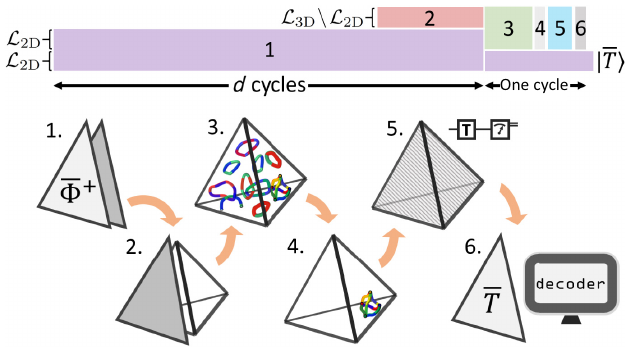
FIG. 29. Protocol to create an encoded T state via code switch- ing, with the timeline of each step in units of QEC cycles for the 2D color code. In steps 1 and 2 we simultaneously prepare the Bell state | (cid:19) + (cid:2) in a pair of 2D codes, and the interior of the 3D subsystem color code. In step 3, we measure gauge operators, before fixing them in step 4 to end up in the 3D stabilizer color code. In step 5, T is applied and all the qubits are measured. In step 6, a decoder is used to infer the outcome of the logical X of the 3D stabilizer color code, and the state of the remaining 2D patch is | T (cid:2) up to a logical Z